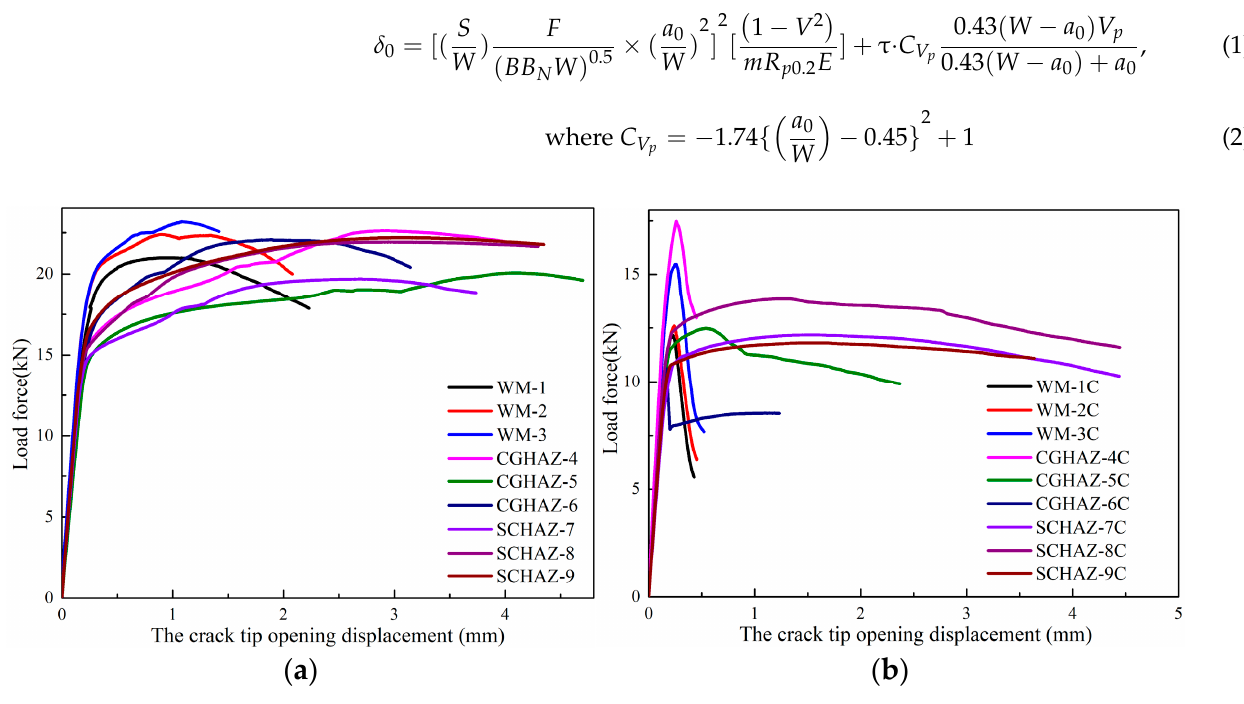
Figure 6. The loading curve of the CTOD test: ( a ) air environment, ( b ) hydrogen sulfide medium.